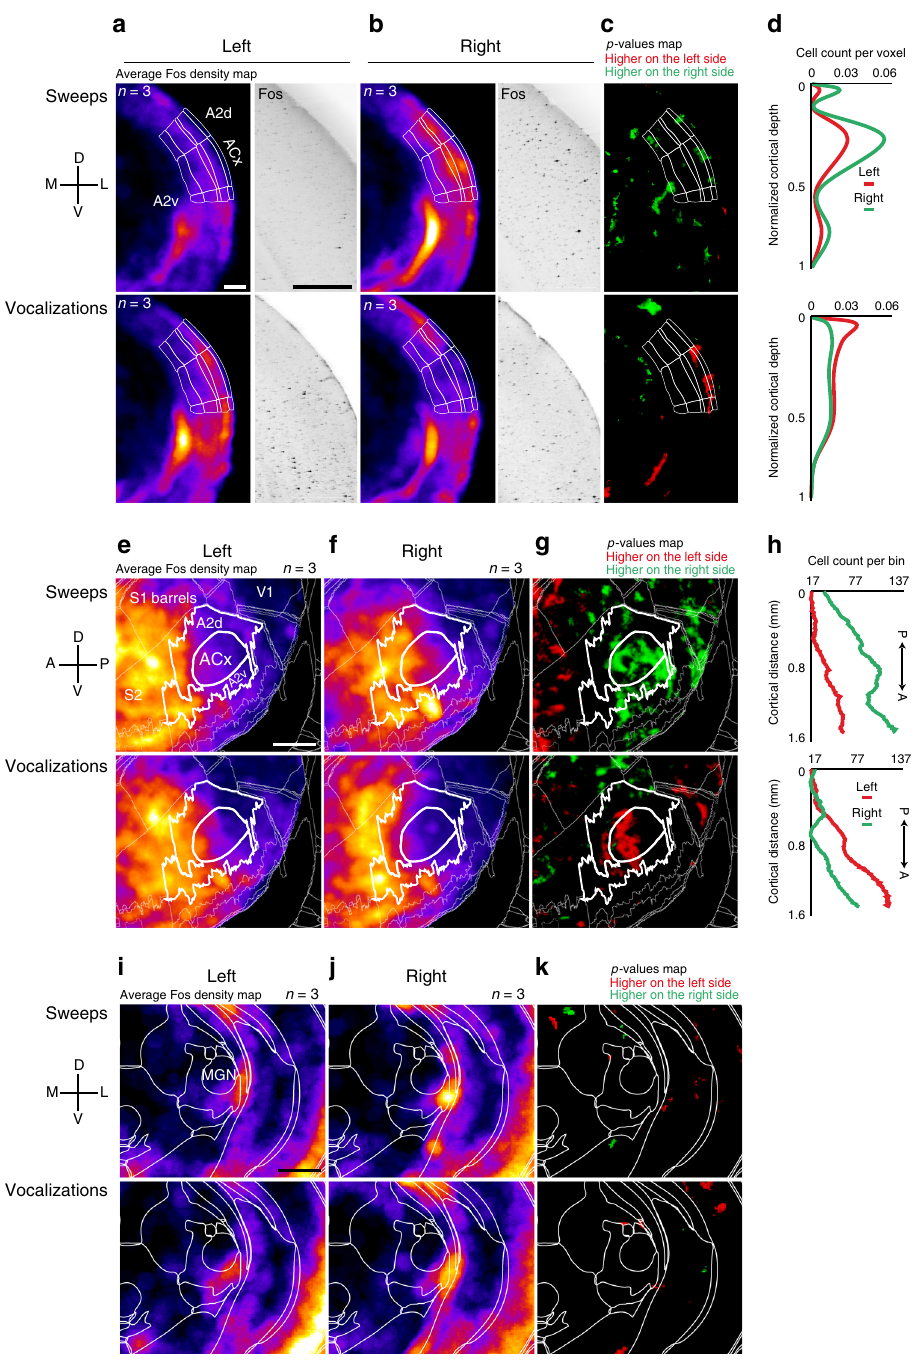
Fig. 1 Sweeps and mouse vocalizations evoke lateralized activation in the ACx. a Coronal plane showing average Fos density (left) and Fos-positive cells stack (right) for sweeps (top, n = 3 mice) and vocalizations (bottom, n = 3 mice) in the left ACx; scale bar 0.5 mm. b Same as ( a ) but showing the right ACx. c Maps of statistically signi fi cant differences in activation between the left and right hemispheres. Sweeps evoked higher activation in the right ACx (top), and vocalizations evoked higher activation in the left (bottom). d Laminar distribution of cell count per imaging voxel (25 μ m 3 ). e , f Lateral cortical projection showing average Fos density for sweeps (top, n = 3 mice) and vocalizations (bottom, n = 3 mice) in the left and right hemispheres (respectively); scale bar 1 mm. g Maps of statistically signi fi cant differences in activation between the left and right cortical projections. Sweeps evoked higher activation in the right ACx (top), and vocalizations evoked higher activation in the left (bottom). h Distribution of cell count along the tonotopic axis. The y axis represents the number of cells in super fi cial layers in neighborhoods of 190 µ m around each point on the line drawn. i , j Coronal plane showing average Fos density in the auditory thalamus (MGN), for sweeps (top, n = 3 mice) and vocalizations (bottom, n = 3 mice) in the left and right hemispheres (respectively); scale bar 1 mm. k Statistical maps showing no signi fi cant difference in activation between the left and right MGN